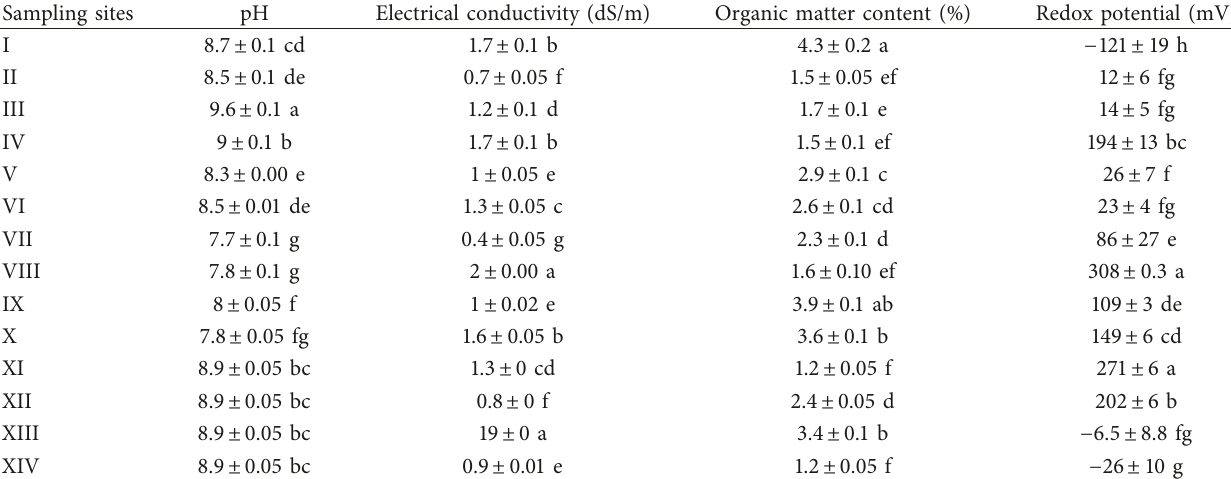
Table 4: Mean and standard errors of physicochemical characteristics of soils and sediments from the La Zacatecana Lagoon. Sites denoted by different letters in the same column differ significantly at p < 0 . 05 in one-way ANOVA tests (Tukey’s post hoc